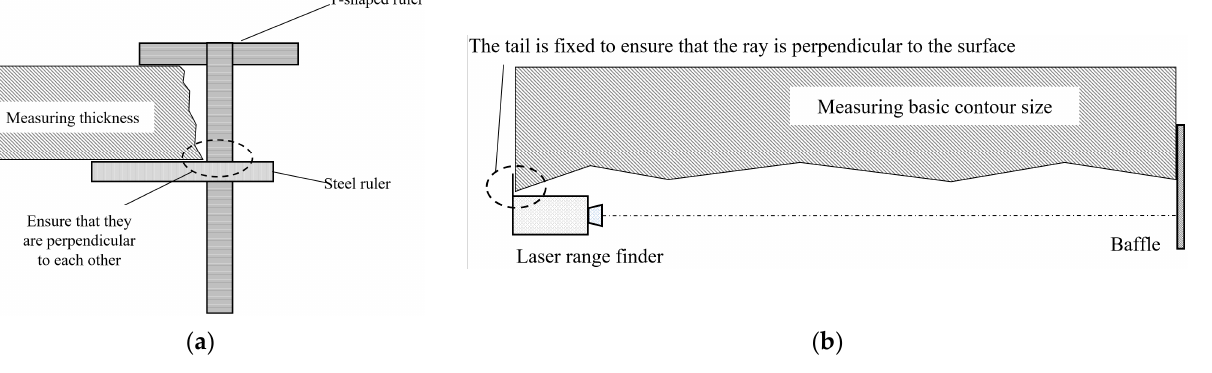
Figure 9. Measurement tools and usage. ( a ) Thickness measurement method, ( b ) Measurement method of outline dimension.